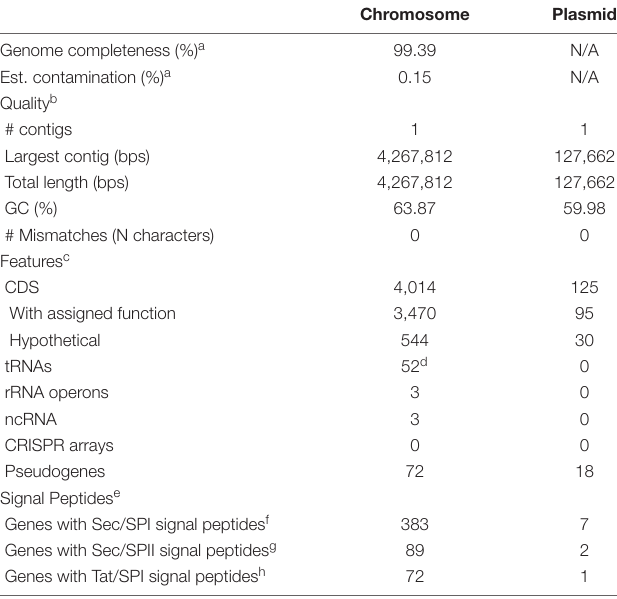
TABLE 1 | Genome assembly and quality statistics for Thioclava electrotropha ElOx9 T